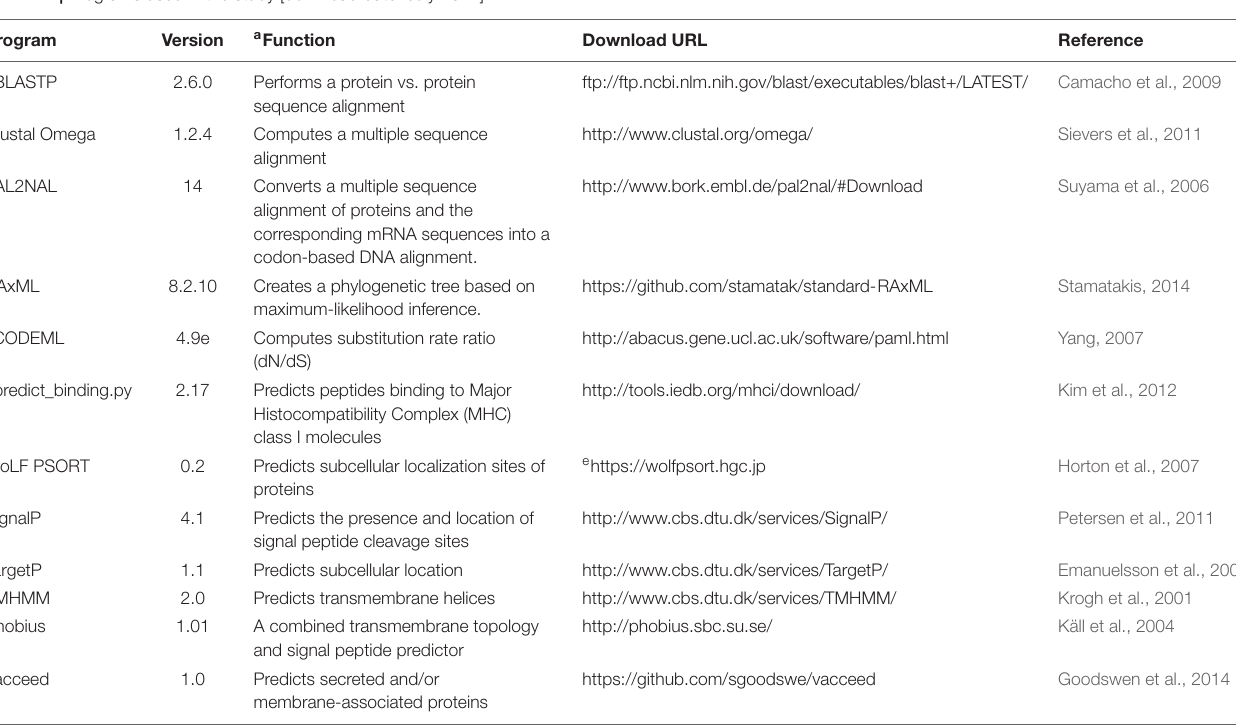
TABLE 2 | Programs used in the study [download date: July